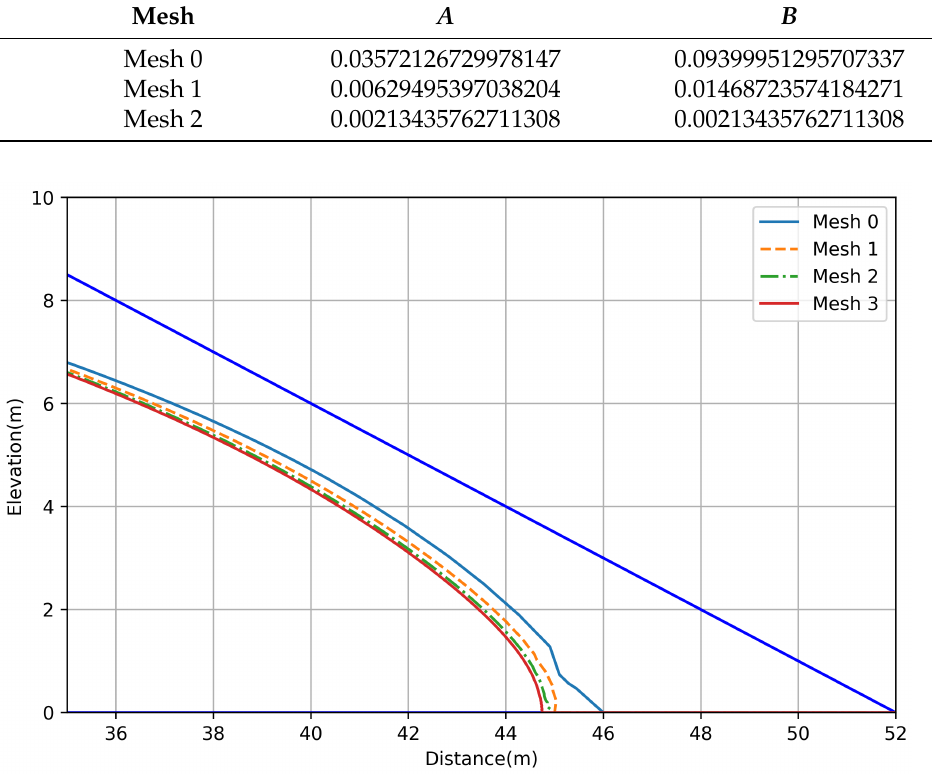
Figure 4. Calculated phreatic levels using the grids (a–d) shown in Figure